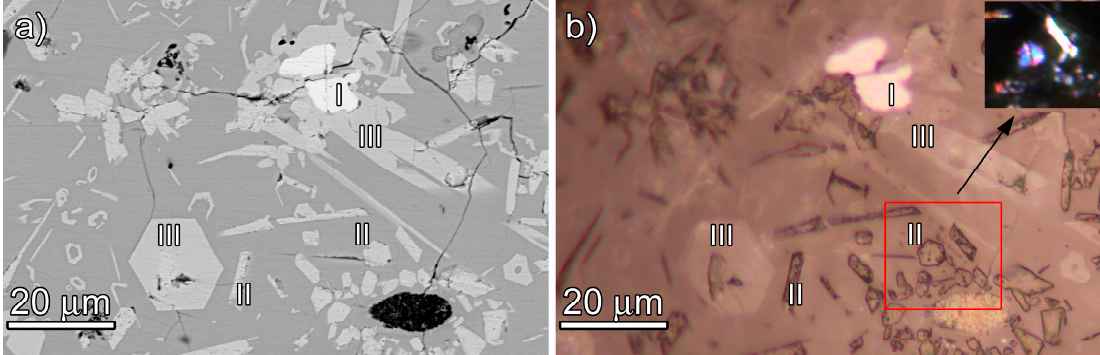
Figure 6. ( a ) A SEM backscattering image of the ceramic glaze: In the BSE image, the brightest grains (I) correspond to galena, while lanarkite (II) and mattheddleite (III) are darker and cannot be differentiated. ( b ) The same area as in Figure 6a in reflected light (RL): Galena (I) appears very reflective while lanarkite (II) shows a pronounced negative polishing relief and a lower reflectivity compared to mattheddleite (III); the inset is the hexagonal section of lanarkite under cross-polarized light (XPL). The images are adapted from Di Febo et al. (2017) [32] and Di Febo, 2016 [48].